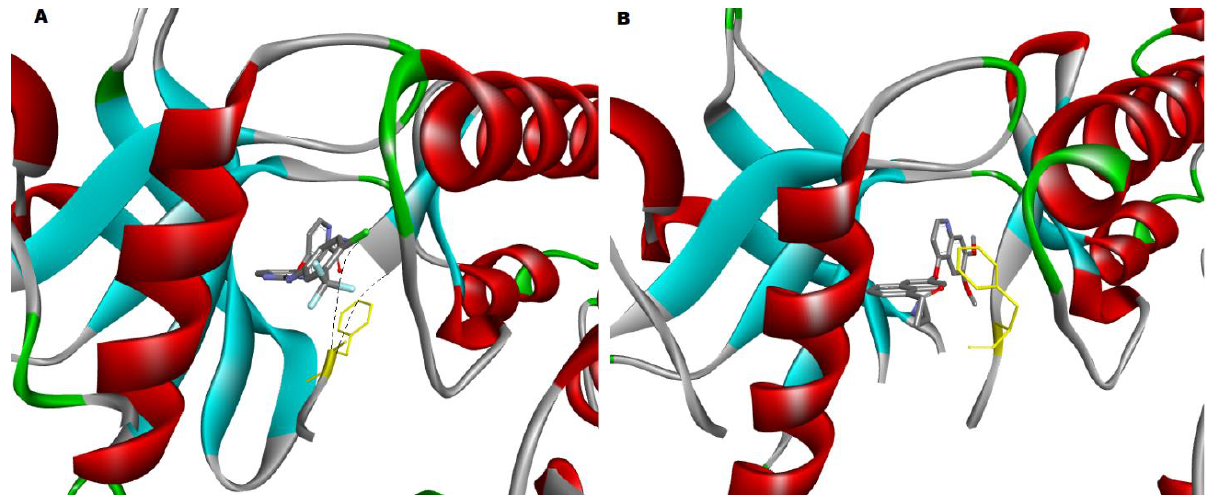
Figure 5. ( A ) The crystal structure of the VEGFR2 kinase domain in complex with a benzimidazole inhibitor (2QU5) has the phenylalanine (highlighted in yellow) of the DFG motif facing much closer to the surface of the active site; therefore, it is in the inactive DFG-out state, and ( B ) The crystal structure of the VEGFR2 kinase domain in complex with a naphthamide inhibitor (3B8R), showing that the DFG motif has the phenylalanine (highlighted in yellow) facing in towards the center of the pocket between the N-lobe and C-lobe; therefore, it is in the active DFG-in state. The two PDB-derived structures were visualized by Discovery Studio v21.1.